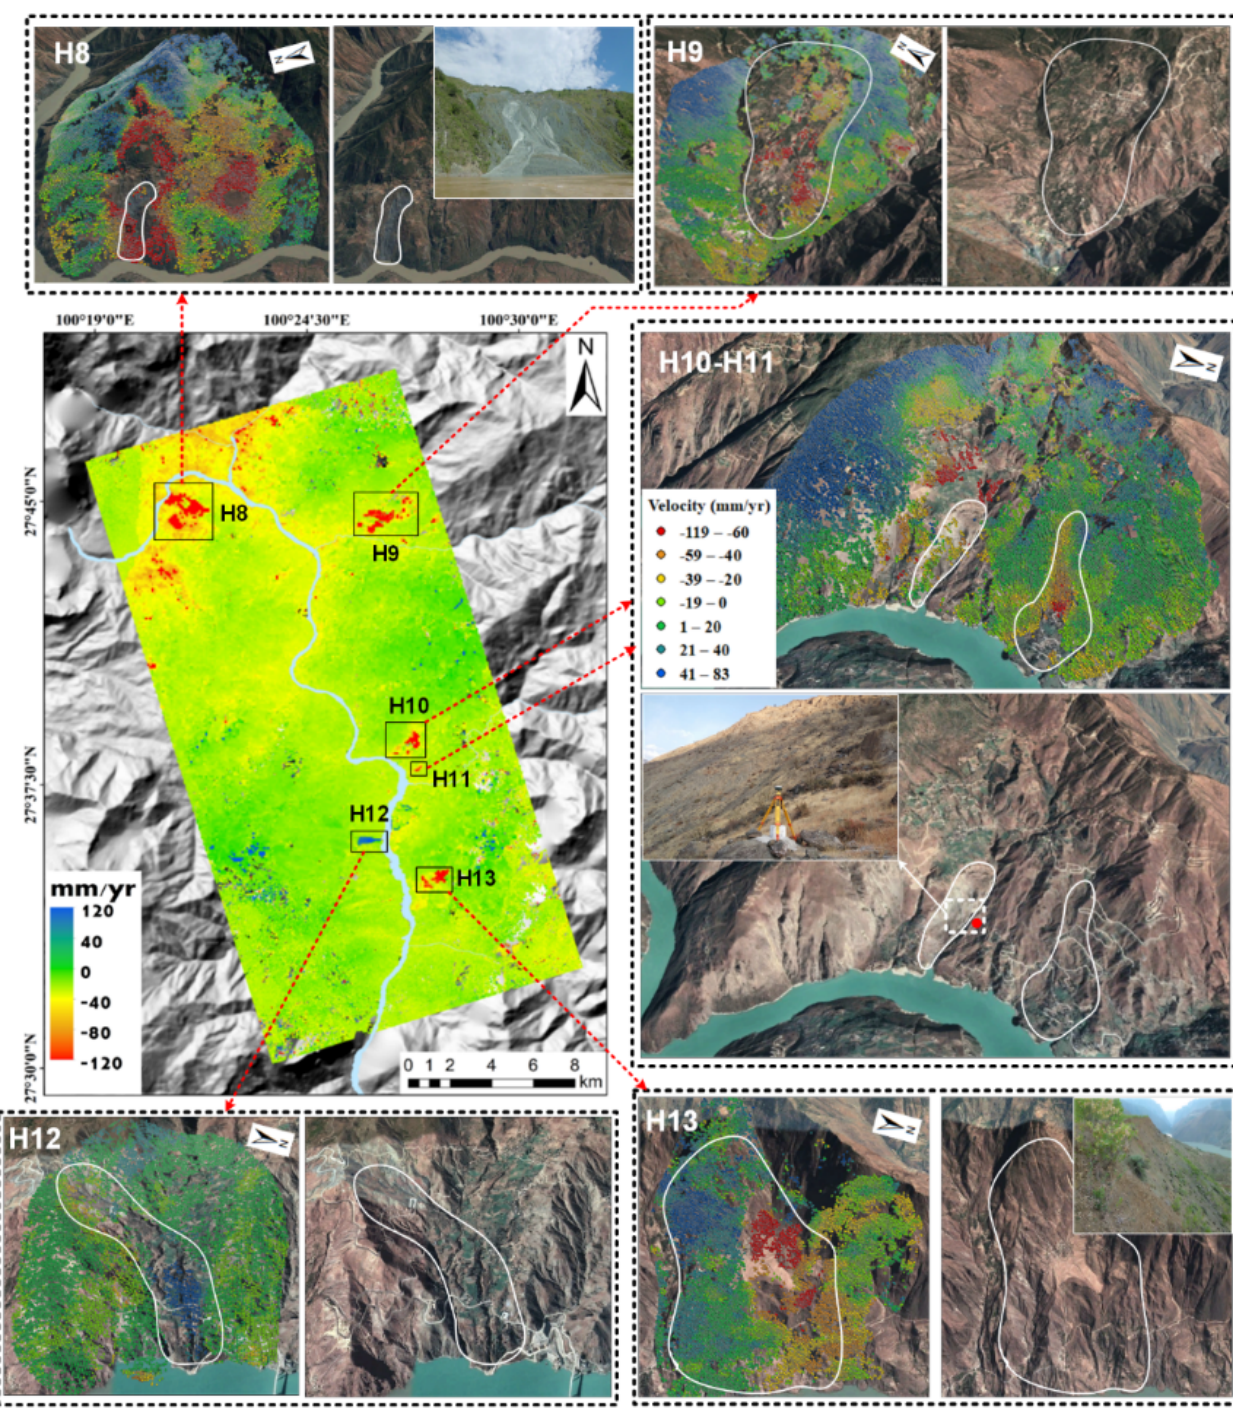
Figure 8. Deformation information obtained from descending Sentinel-1A data and landslide identification results.